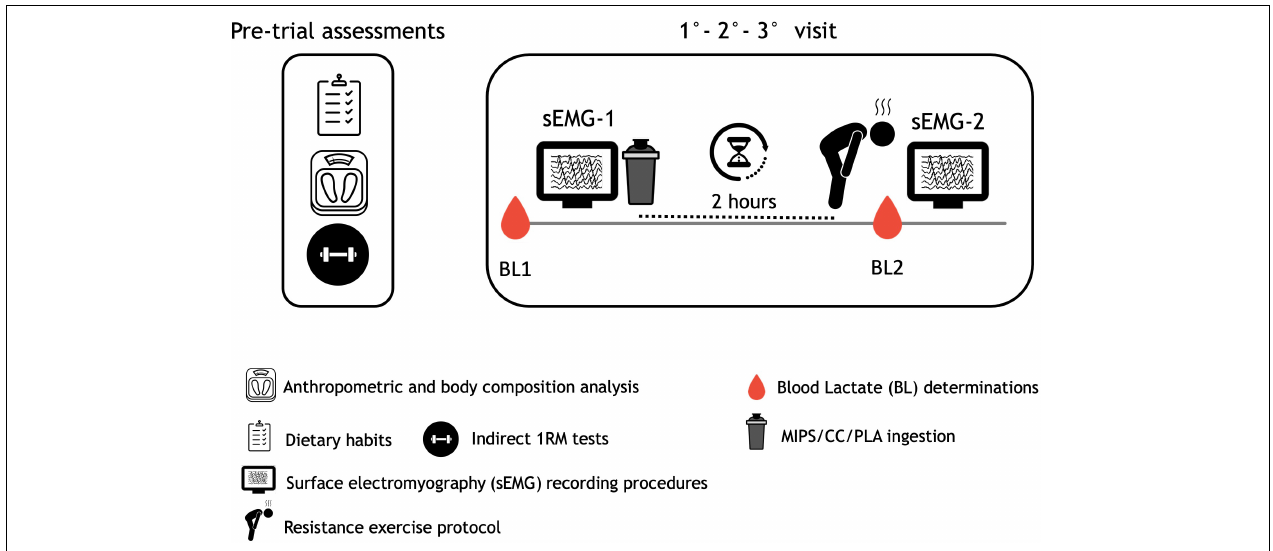
FIGURE 2 | Schematic illustration of experimental